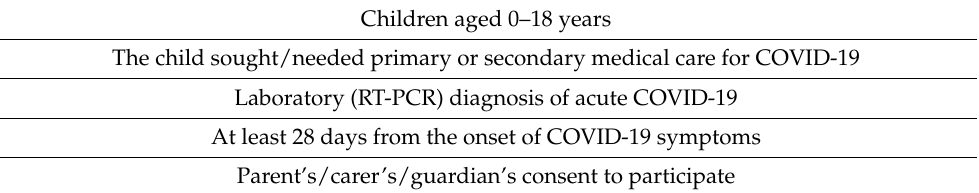
Table 1. Inclusion criteria